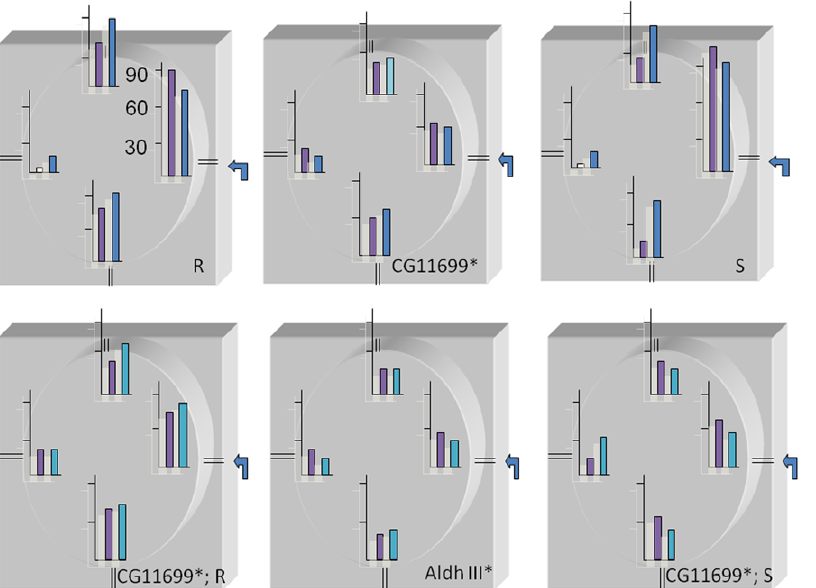
Figure 2. Benzaldehyde-induced response of double homozygous mutants bearing a CG11699 allele in a Rover or Sitter genetic background conferring distinct dispersive behavior. Ten flies (five days old females in purple, males in blue) were starved for two hours